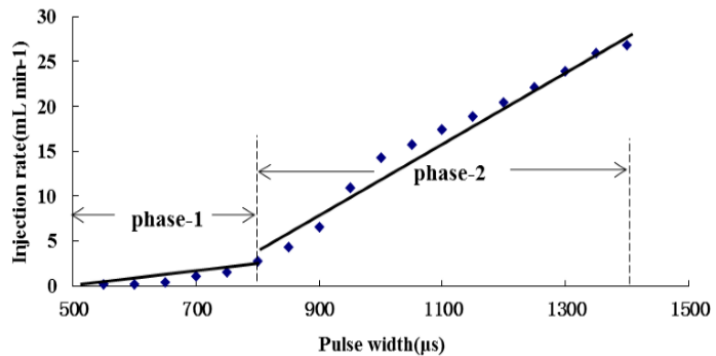
Figure 10. Sectional linear input-output characteristic of RRV.